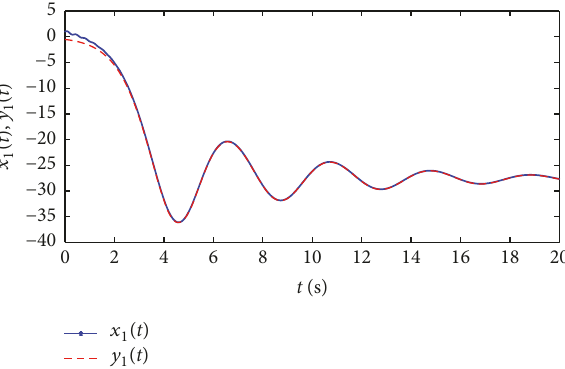
Figure 5: The controlled state trajectory of 𝑥 1 and 𝑦 1 .